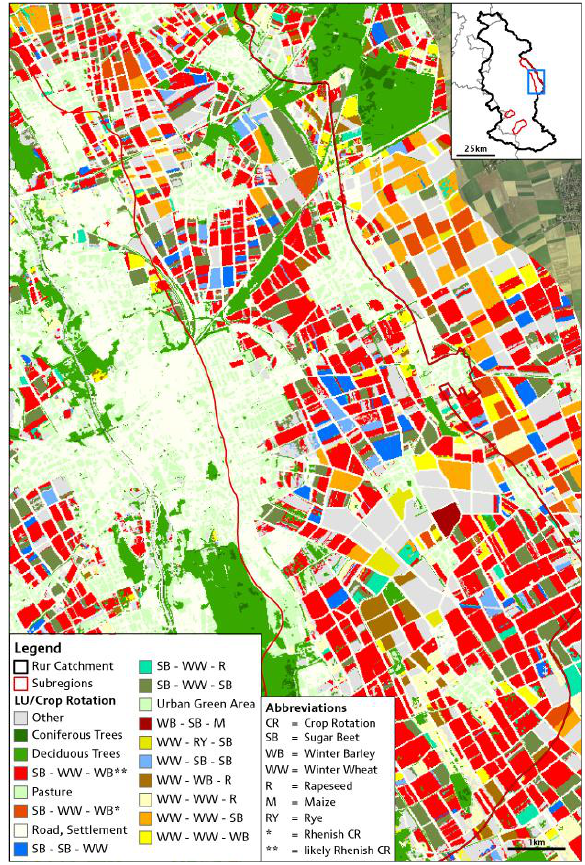
Figure 10. Crop rotation map 2007-2009 for the Rur- Watershed (Waldhoff et al.,